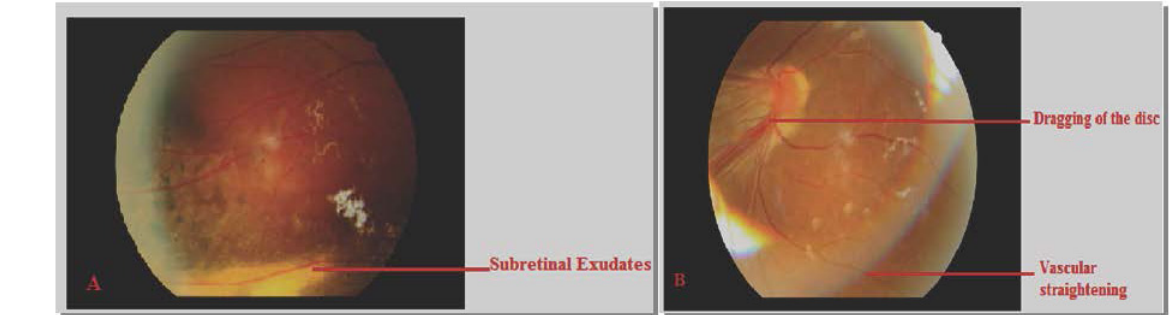
Figure 2A: Showing fundus photography findings of the right eye. A mass of subretinal exudates have settled inferiorly. Figure 2B shows temporal dragging of the optic disc and peripheral vascular straightening of the blood vessels in the right eye.